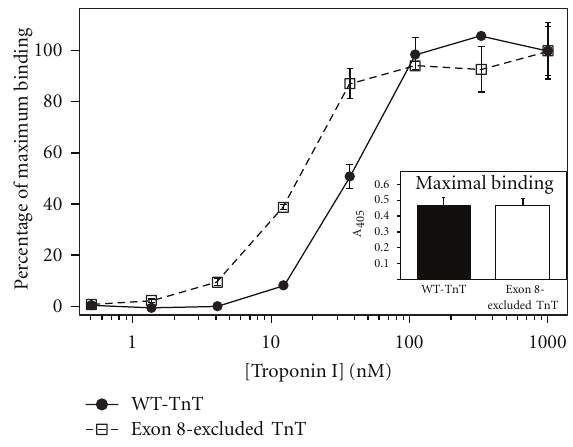
Figure 3: A set of typical, original protein-protein binding curves demonstrating the altered binding of an exon 8-excluded cardiac troponin T (exon 8-excluded TnT, white square) to the interacting protein troponin I in comparison with wild-type cardiac troponin T (WT-TnT, black circle). The troponin T variants are configured as the immobilized protein and troponin I the soluble protein. The normalized binding curves demonstrate exon 8-excluded TnT bound with higher a ffi nity to troponin I compared to WT-TnT as evident by the lower concentration required for 50% maximal binding. Absolute absorbance of the maximal binding is shown in the inset demonstrating that both exon 8-excluded TnT and WT- TnT exhibited similar coupling strength to troponin